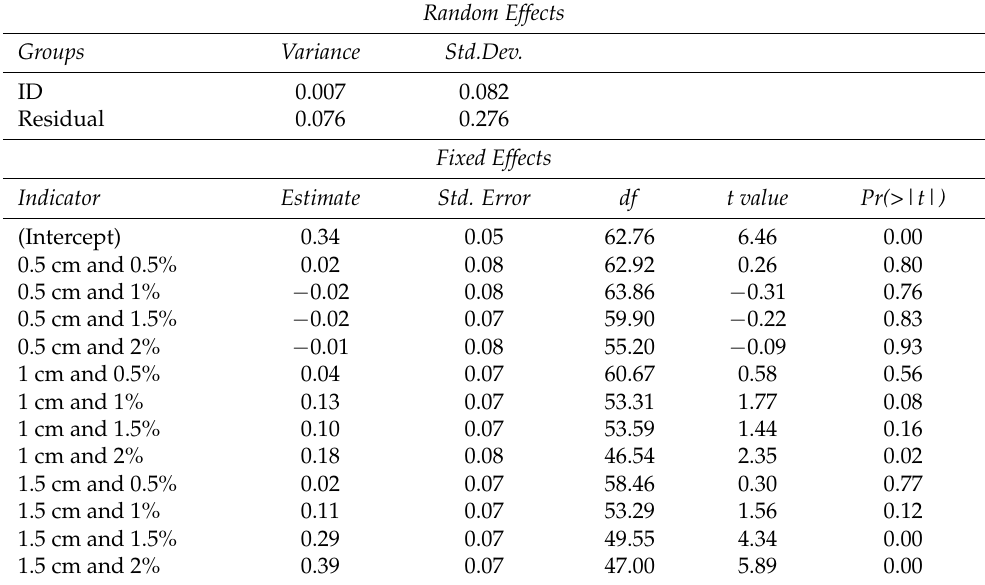
estimation procedure was computed using